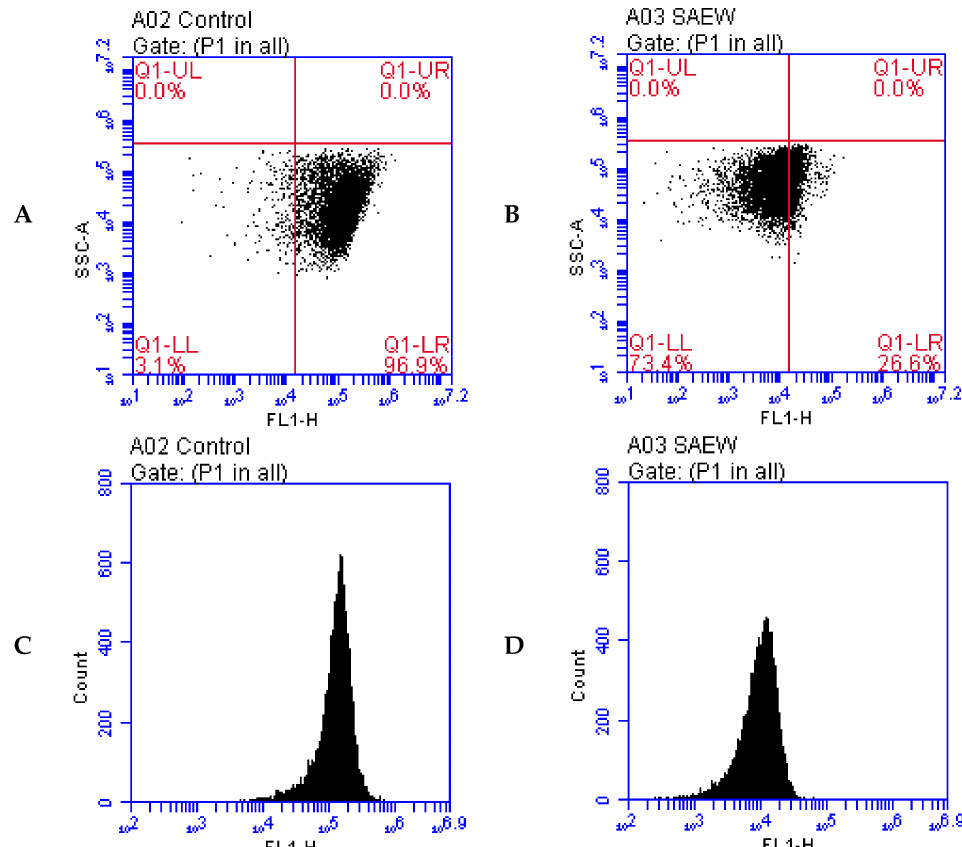
Figure 5. Effect of SAEW(slightly acidic electrolyzed water) on DNA damage in L. monocytogenes observed by flow cytometry (FCM) including: ( A , C ) fluorescence dot plots and counts of L. monocyto- genes as control, ( B , D ) fluorescence dot plots and counts of L. monocytogenes treated by SAEW. SAEW with ACC(available chlorine concentration) of 6.03 ± 0.13 and pH of 5.76 ± 0.03 was used for 60 s in the